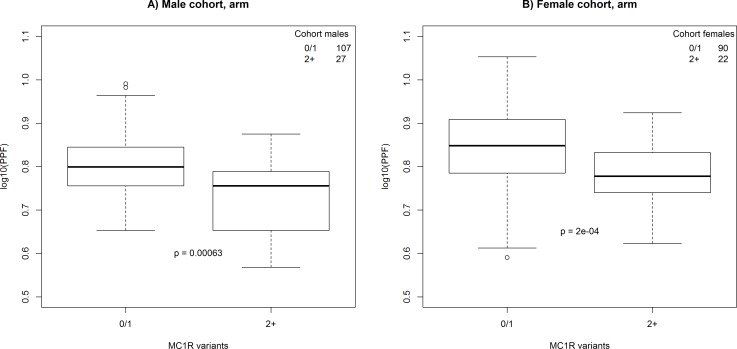
Comparison between skin colour measurements of the arm in male and female cohort individuals with ≤1 or ≥2 MC1R variants.P-values were calculated using Welch’s two sample t-test.